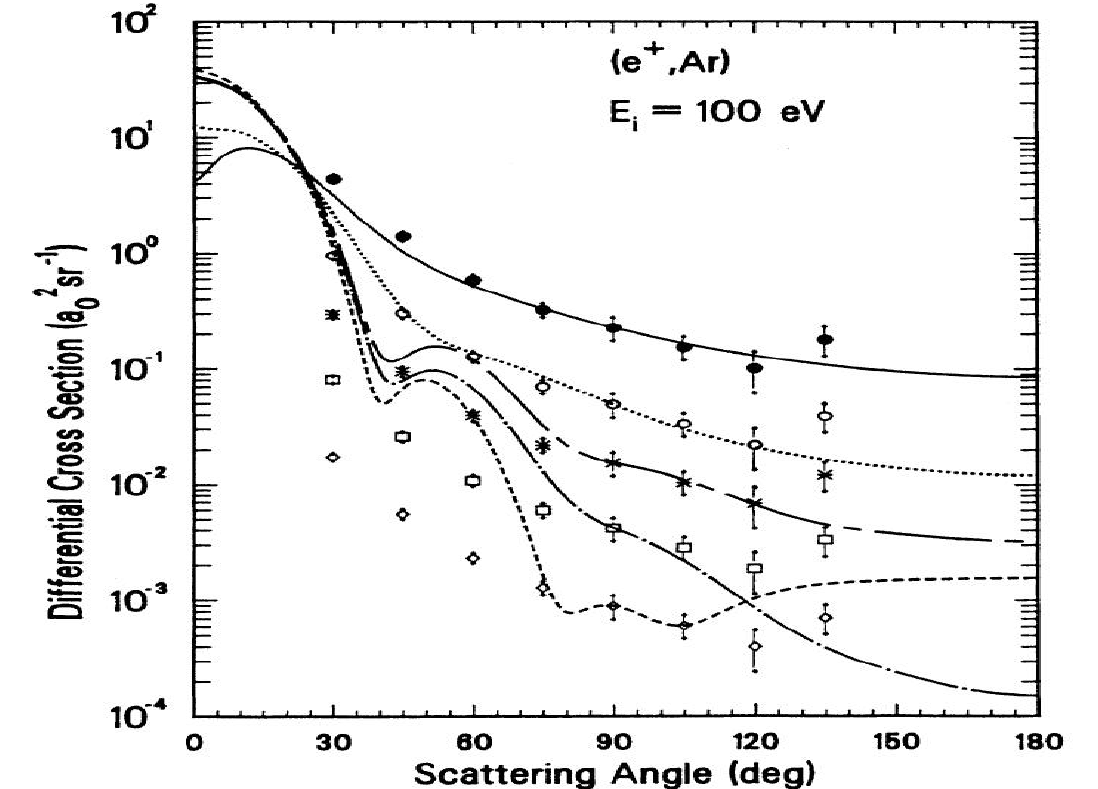
Figure 4. Differential cross sections (DCS) for elastic scattering of positrons from Ar at 100 eV illustrating features and comparison between theory [9] and experiment [27]. The experimental values have been normalized at 90 ◦ with different symbols to differentiate curves to compare the differences in DCS values with different absorption